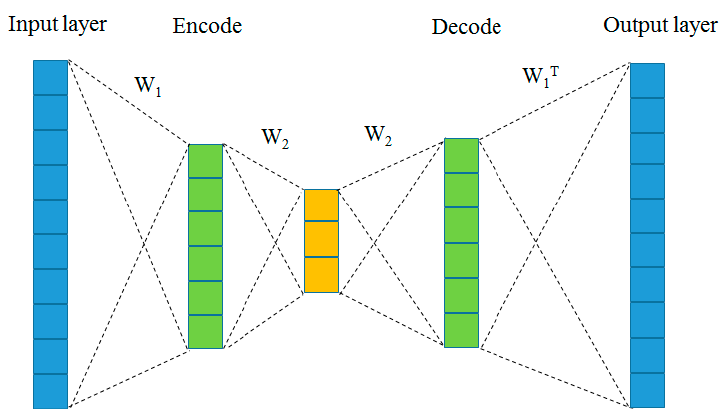
Figure 3. Proposed DAE tied-weights neural network.